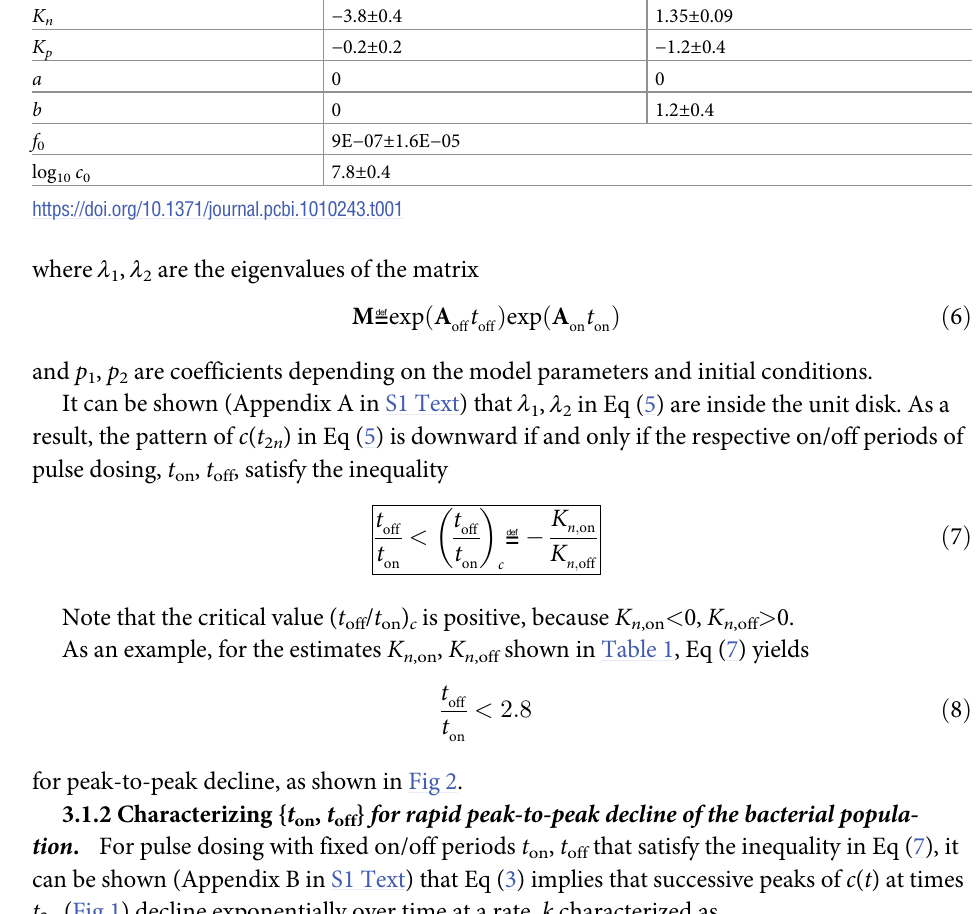
Table 1. Parameter estimates fitting the experimental data of Fig 6. (standard errors reported). Parameter Antibiotic